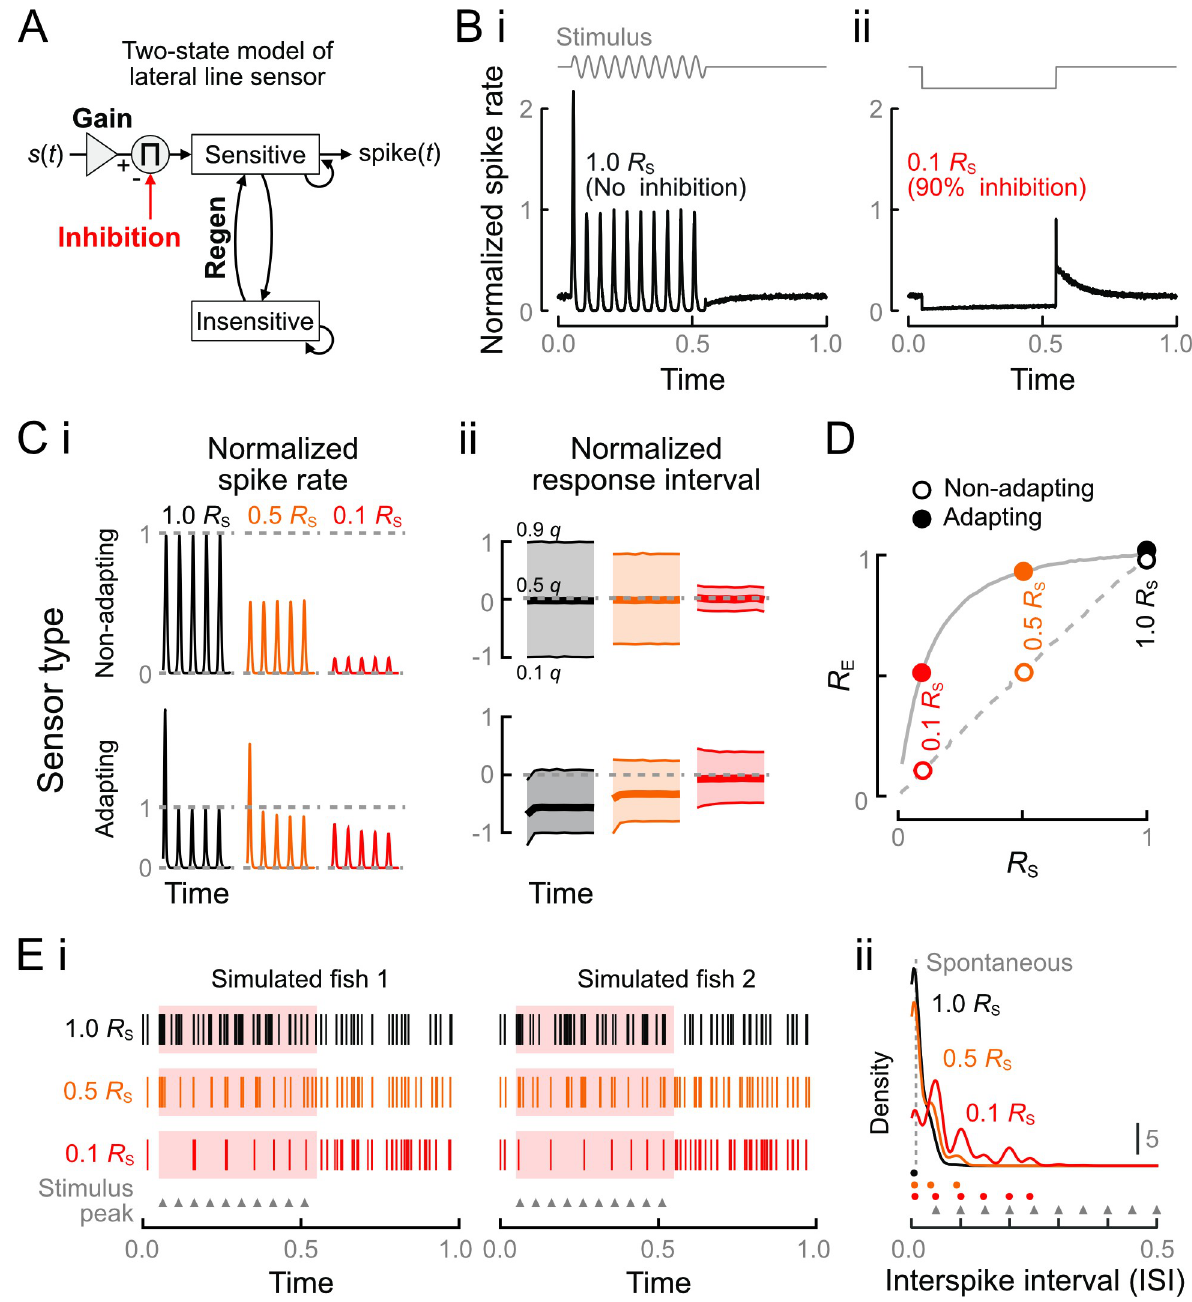
Fig 7. Computational model of the effects of heterogeneity on lateral line sensing. (A) (i) Schematic of the 2-state model of lateral line feedback. The input stimulus is transduced by a sensor with variable gain and regeneration rates. The simulated sensor responds probabilistically to the stimulus only while in its sensitive state, after which it transitions to and remains in the insensitive state until regeneration. Tuning of the gain and regeneration constants was used to model adapting and nonadapting response types when subject to inhibition of strength R S . (B) Simulated responses of an adapting sensor to stimulation with no inhibition (i) or to strong inhibition in the absence of stimulation (ii). Our model recapitulated the observed changes in spike rate in each condition. After stimulation, the sensor exhibited a refractory period before recovering spontaneous spike rates, whereas after suppression it exhibited rebound spiking. (C) Adaptation rates determine the dependence of spike count (i) and phase interval (ii) on inhibition. Nonadapting responses were constant over time and both spike count and response intervals were reduced proportionately to R S . Responses of adapting sensors were nonlinear over time and with respect to inhibition strength, although the nonlinearities were largely suppressed by the strongest level of inhibition (0.9 R S ). Spike counts and phases were normalized to the steady states with 1.0 R S . (D) Nonadapting responses maintained R E = R S for all R S , whereas R E > R S for all R S < 1 in adapting responses, supporting the observed response clusters in Fig 6. Dashed and solid gray lines denote the trajectories of nonadapting and adapting responses at inhibition strength intervals of